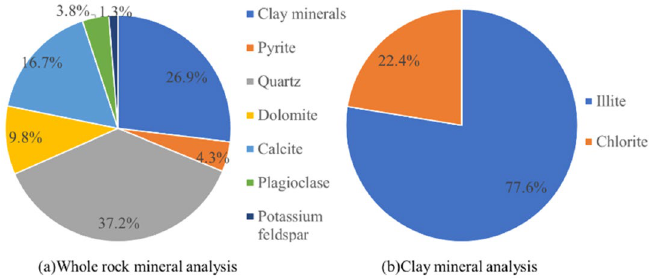
Figure 3. Mineral composition of shale.